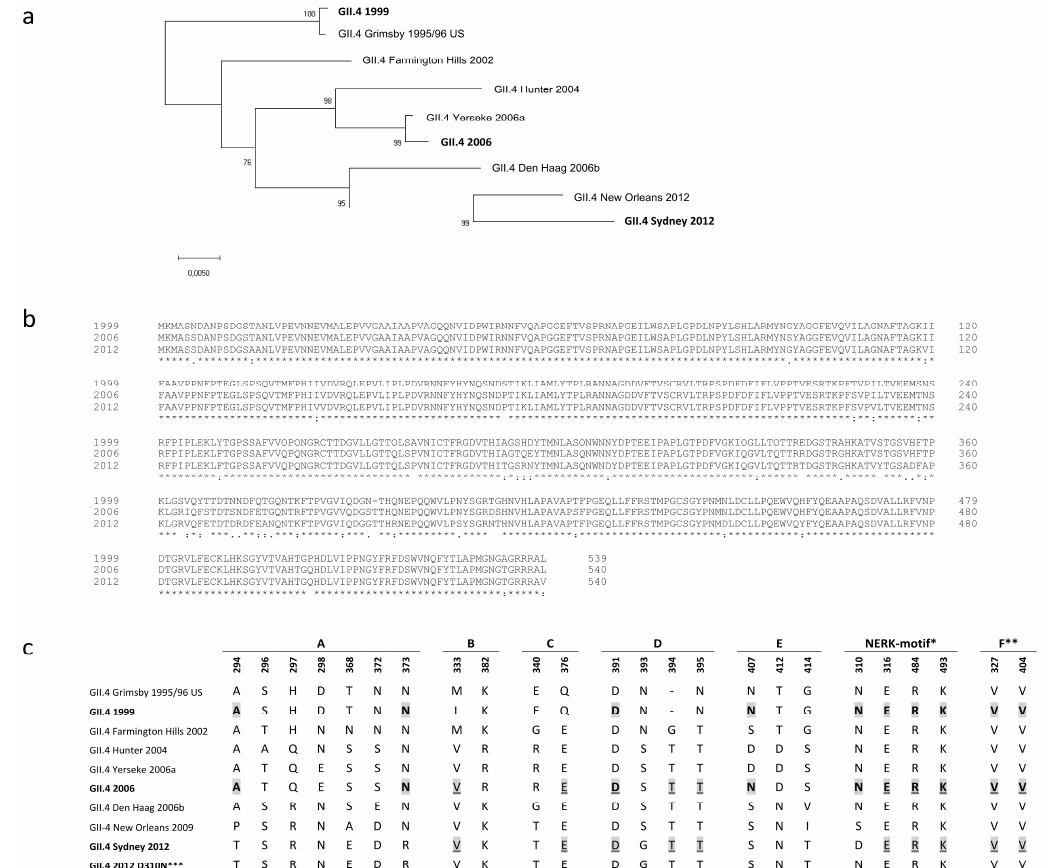
Figure 6. Phylogenetic tree and the amino acid (aa) sequences within blocking epitopes A–F and the NERK motif based on the VP1 amino acid sequences of norovirus (NoV) GII.4 strains. The tree illustrates the phylogenetic analysis of seven pandemic GII.4 NoV major capsid protein VP1 aa sequences with the GII.4 variant VP1 sequences used as virus-like particles (VLPs) in this study (boldface) ( a ). The tree was inferred by neighbor-joining method with a bootstrap of 1000 by using MegaX. The percentages of replicate trees in which the associated taxa clustered together in the bootstrap test (1000 replicates) are shown next to the branches. The evolutionary distances were computed using the p-distance method and the scale bar shows the genetic distance, expressed as amino acid substitutions per site. ClustalW VP1 amino acid sequence alignment of GII.4 1999, GII.4 2006, and GII.4 2012 variants used as VLPs in this study ( b ). Asterisk (*) indicates fully conserved amino acids, colon (:) indicates conservation between groups of strongly similar properties and period (.) indicates conservation between groups of weakly similar properties. Amino acid sequences of blockade epitopes A to F and the NERK motif [21,25,31] in GII.4 variants ( c ). Identical amino acids between GII.4 1999 and GII.4 2006 are shaded and bolded. Identical amino acids between GII.4 2012 and GII.4 2006 are shaded and underlined. *Motif regulating antibody access to the epitope F [31]. **Critical key residues of blockade epitope F [25]. ***Mutated VLP used in this study. Genbank accession numbers to VP1 amino acid sequences of published GII.4 strains are as follows: AF080551 (1995/96 US), AY502023 (Farmington Hills 2002), DQ078794 (Hunter 2004), EF126963 (Yerseke 2006a), BAG70446 (2006), EF126965 (Den